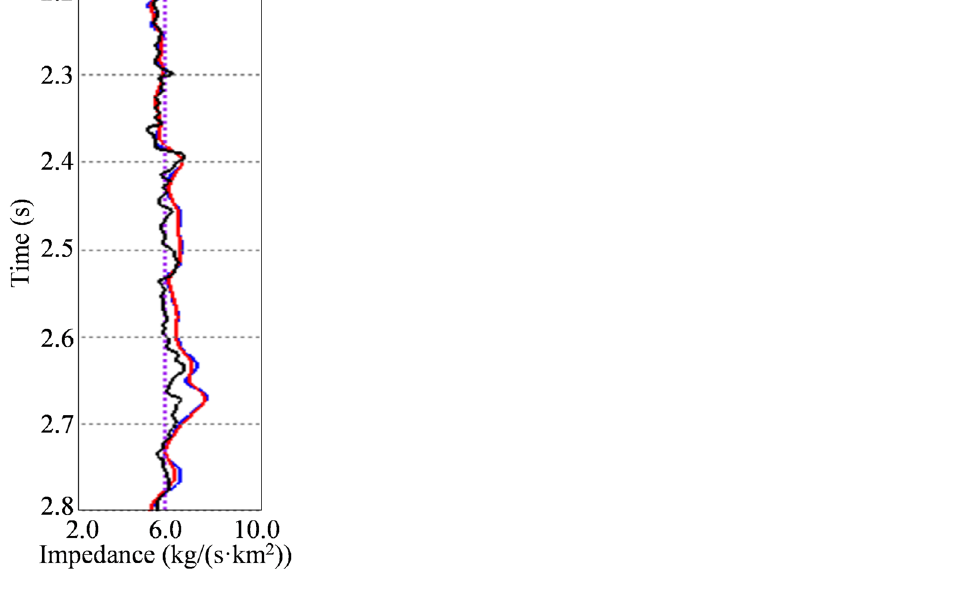
Figure 6. Comparison between actual impedance well log and two different inverted impedances at near-well trace. The black curve is the actual impedance well log, the blue curve is the inverted impedance by L2,0-MI, and the red curve is the inverted impedance by